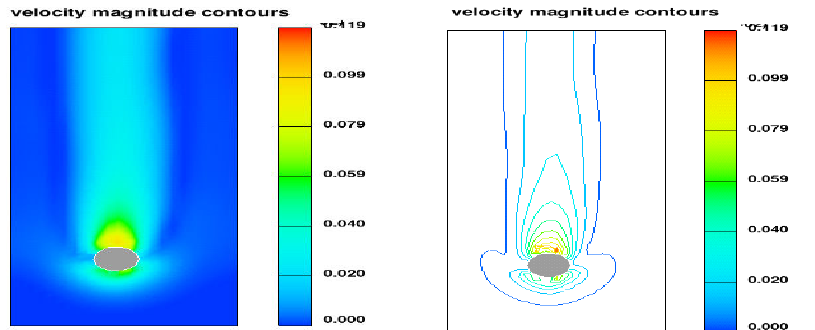
Fig. 2. Velocity magnitude contour of particle with diameter of 1.09 mm